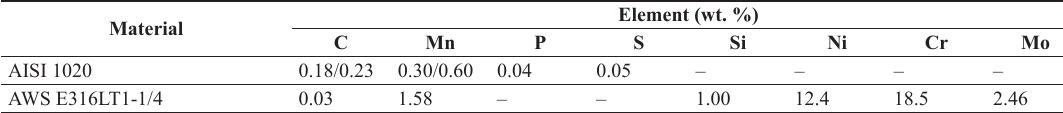
Table 2. Chemical composition of base metal and filler